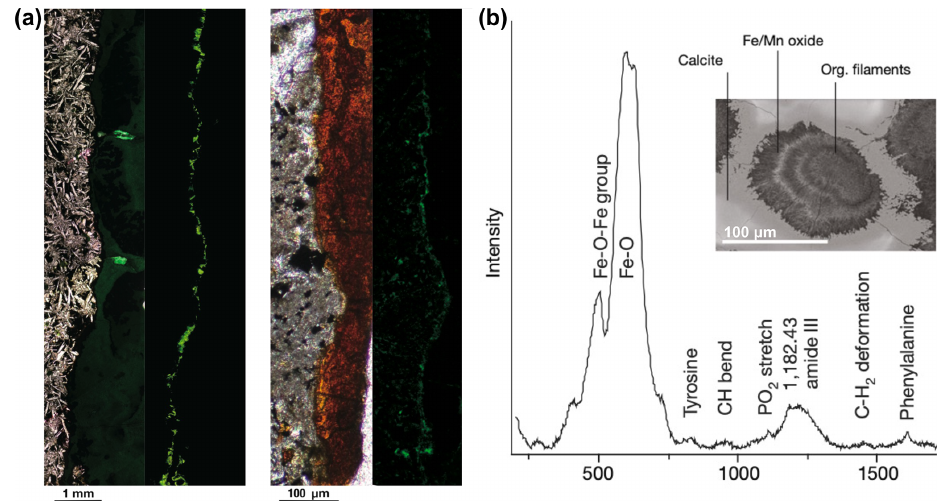
Figure 5. (a) Abundant microbes in secondary minerals (smectite) at basalt–mineral interfaces from IODP Hole U1365E. Light and fluores- cence microscopy images of SYBR Green I-stained microbial cells in a fracture filled with celadonite from U1365E-8R4 and a vein filled with iron oxyhydroxides from Site U1365E-12R2 (Suzuki et al., 2020). (b) Confocal Raman analysis of organic inclusions in calcite from Atlantis Bank (fault-exhumed lower crust), IODP Hole 1473A (Li et al.,